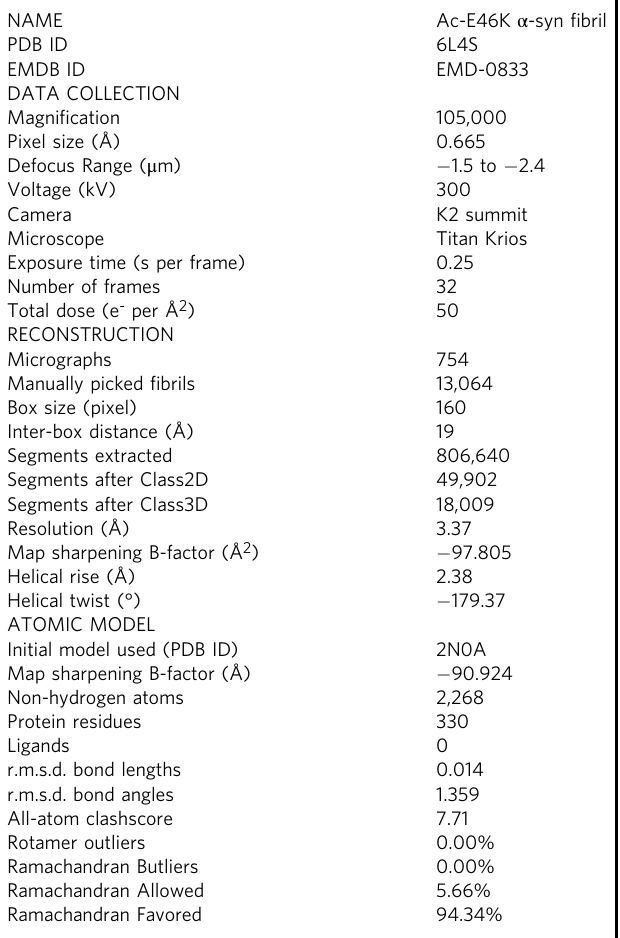
Table 1 Statistics of cryo-EM data collection and re fi nement.